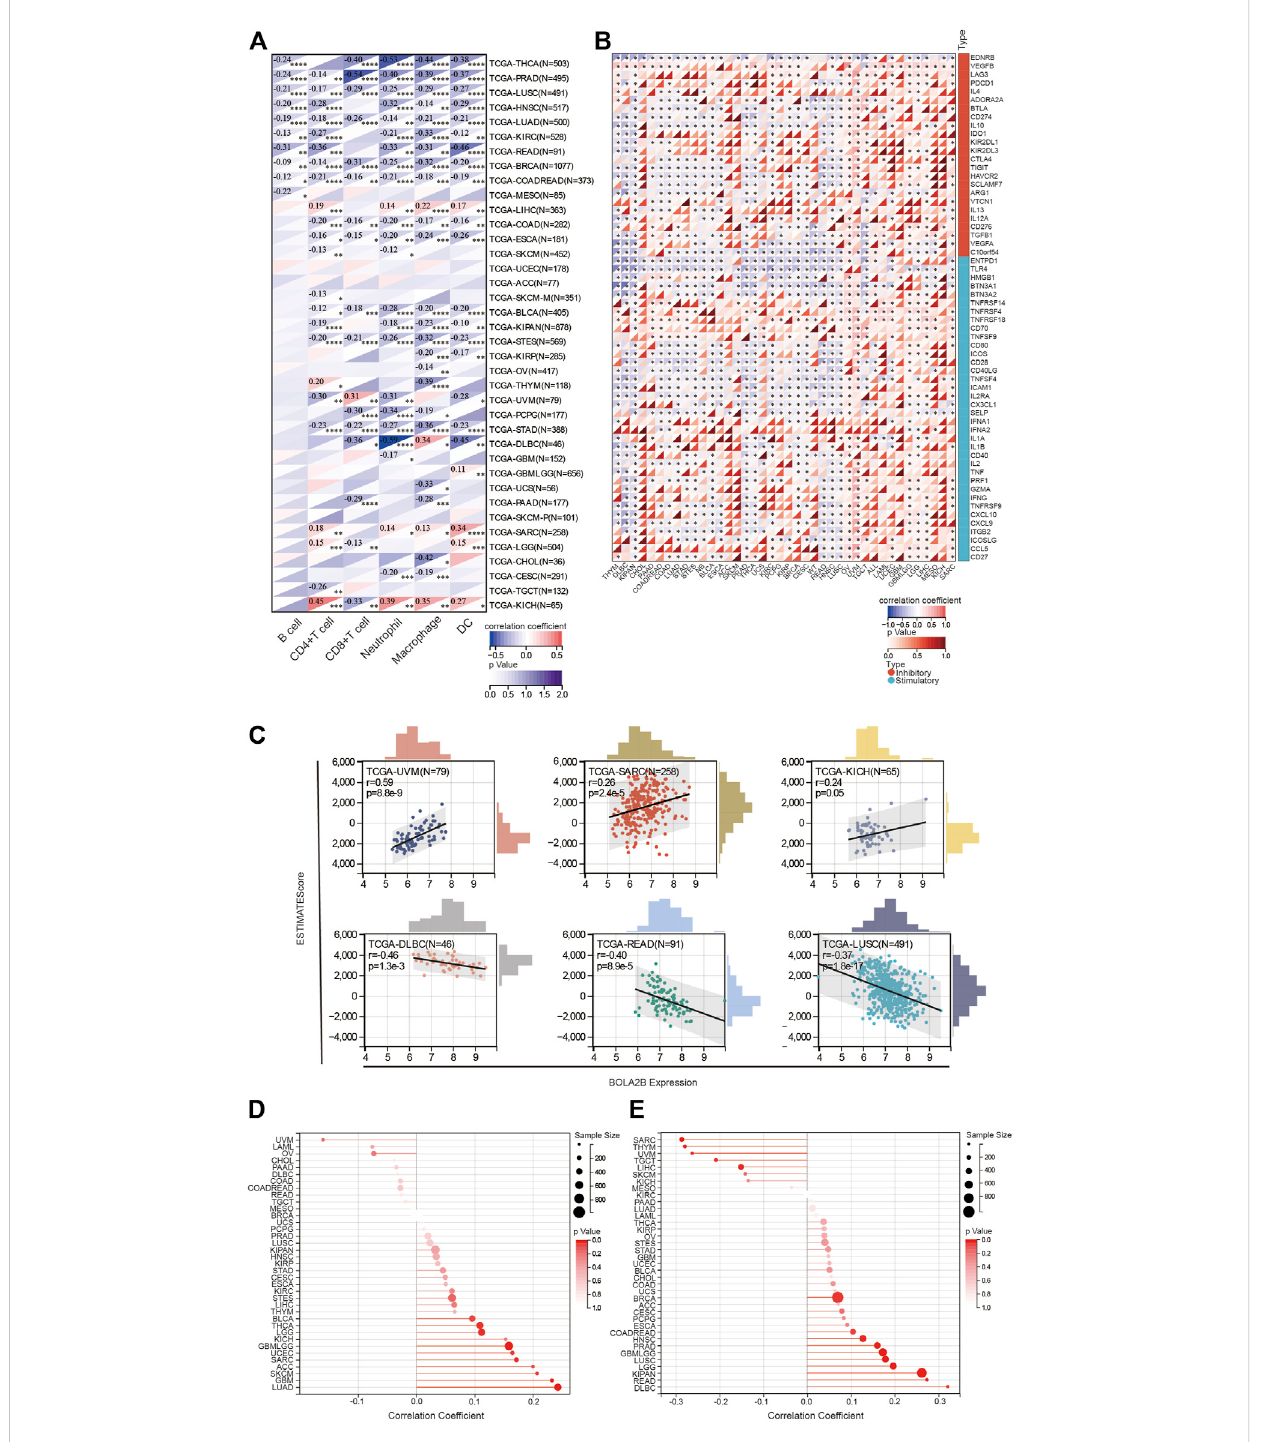
Correlation of BOLA2B expression with immune response. (A) Correlation of BOLA2B with key immune cells in TCGA. (B) Heatmaps of the relationshipofstimulatoryandinhibitoryimmunecytokineswithBOLA2Bacrosscancers. (C) RepresentativeESTIMATEevaluationofBOLA2Bexpression in thetop three cancers. (D) The lollipop plot of BOLA2B association with tumor purity in cancers. (E) The lollipop plot of BOLA2B association with tumor mutational burden (TMB) in